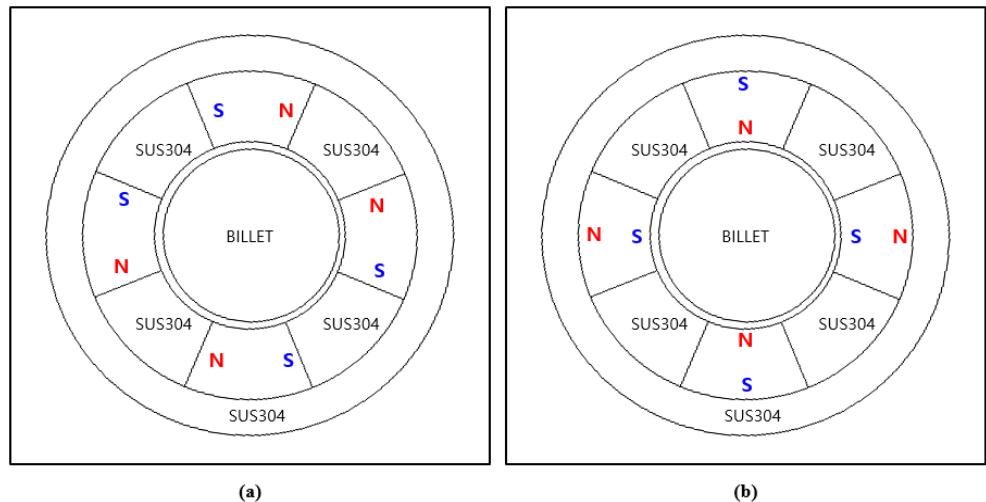
Figure 8. Permanent magnet polarity direction change model: ( a ) tangential direction model; ( b ) normal direction model.